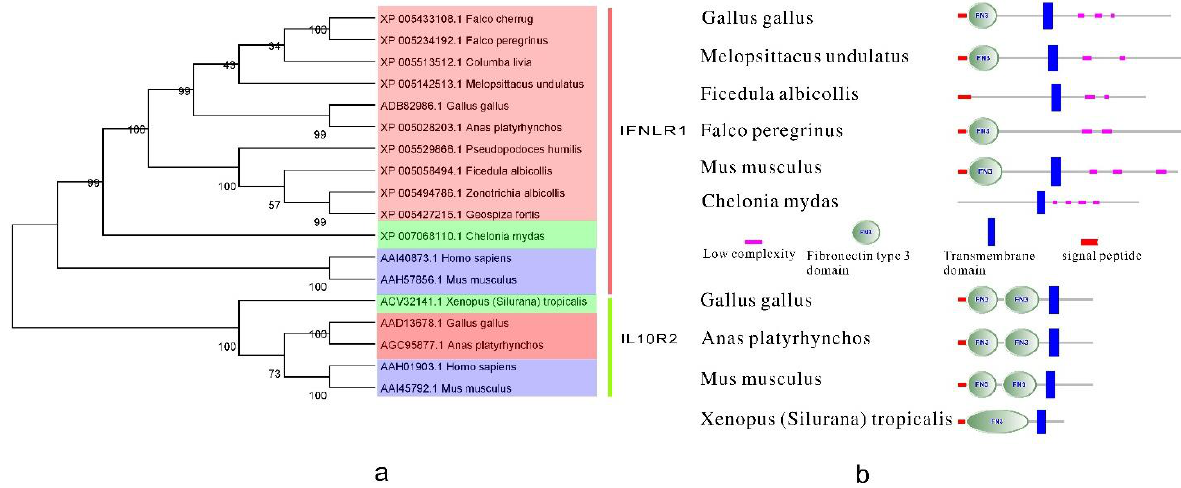
Figure 6. The phylogenetic tree and the protein structure of bird type III IFN receptors. ( a ) The phylogenetic tree of the type III IFN receptors. It was built by MEGA5 program with 1000 bootstrap replicates and based on the neighbor-joining method. Orange (dark or light), green, blue in the picture represent birds, reptiles and amphibians, mammals, respectively; and ( b ) The structure of bird type III IFN receptors. IFNLR1 reference sequences: Gallus gallus [GenBank: ADB82986.1], Melopsittacus undulatus [GenBank: XP005142513.1], Ficedula albicollis [GenBank: XP005058494.1], Falco peregrinus [GenBank: XP005234192.1], Mus musculus [GenBank: AAH57856.1], Chelonia mydas [GenBank: XP007068110.1]. IL10R2 reference sequences: Gallus gallus [GenBank: AAD13678.1], Anas